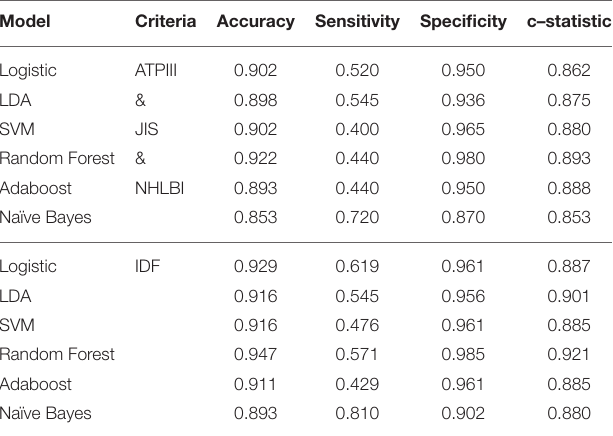
TABLE 3 | Performance of different machine-learning models on predicting metabolic syndrome using ATP III, JIS, NHLBI, and IDF criteria.